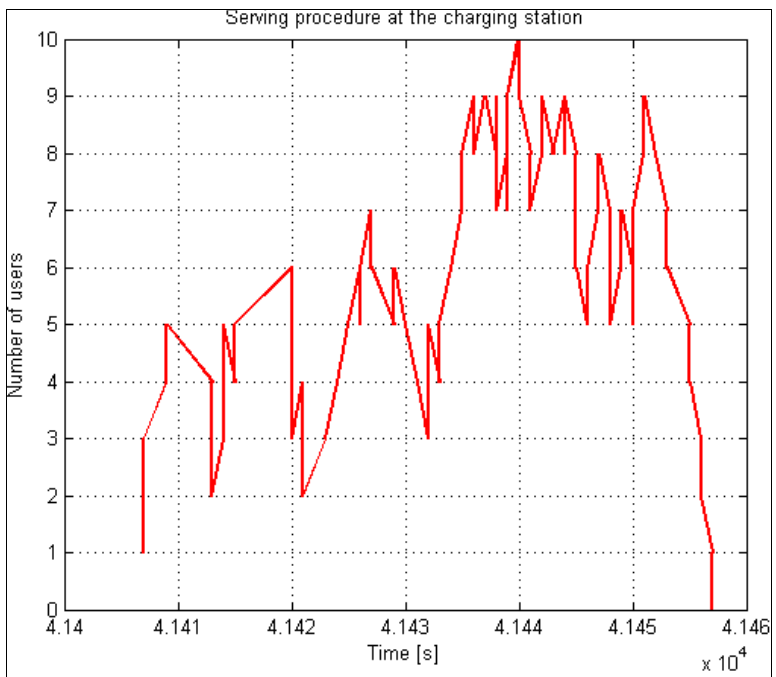
Figure 13. Activity and utilization of the service charging system in the entire observed period. P = 15, U = 47.